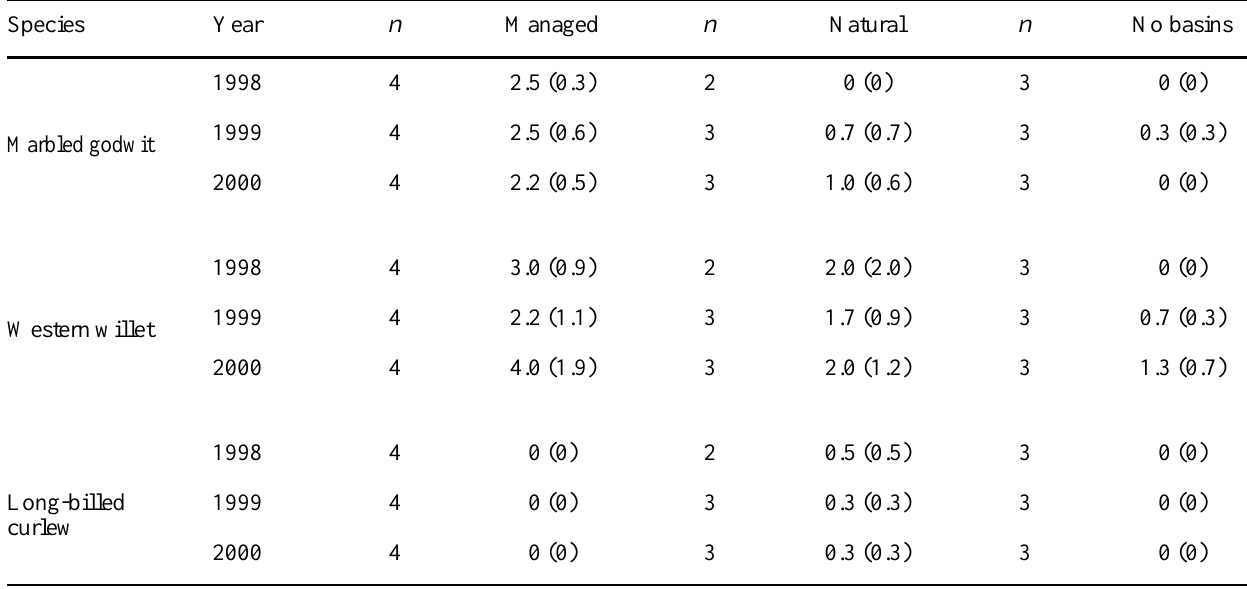
Table 3. Mean number of marbled godwit, western willet, and long-billed curlew nests (+ SE) found in a single nest search of a 2-km 2 area in each of 9–10 survey routes from 1998 to 2000 in southeastern Alberta, where n = number of areas nest searched. Species Year